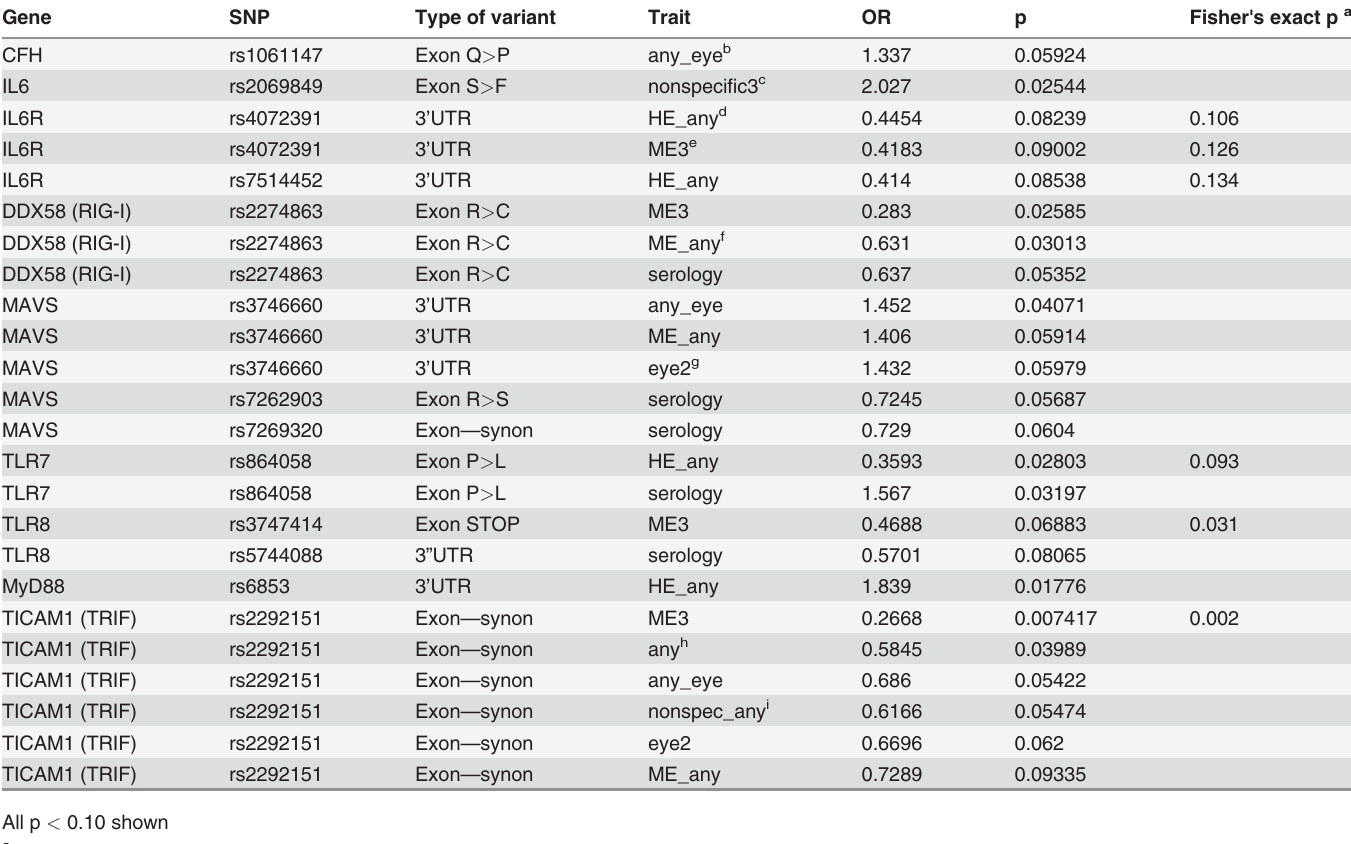
Table 2. Genetic association analysis results from dominant